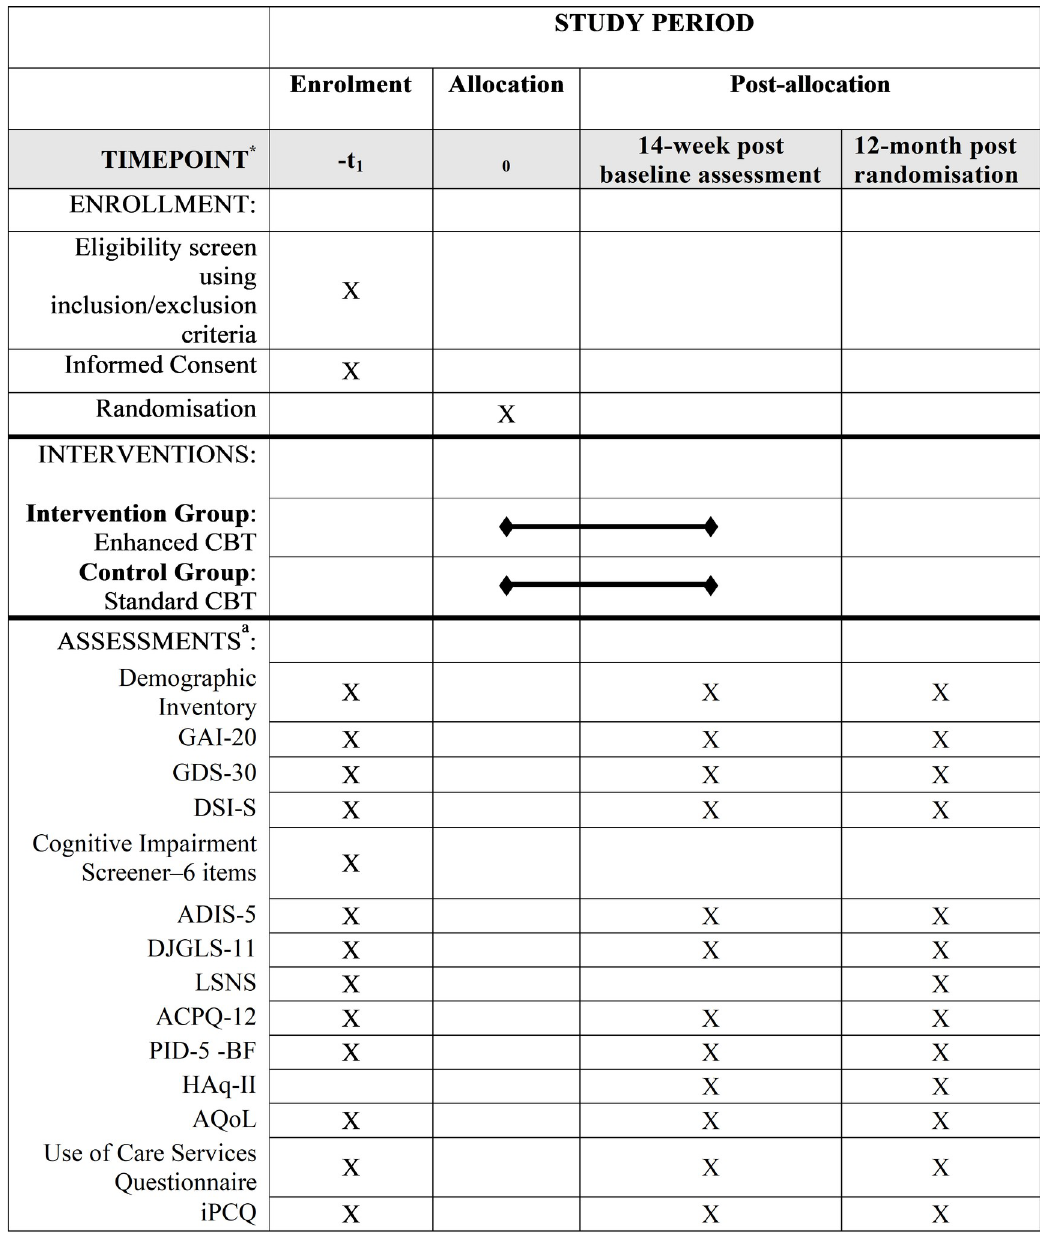
Fig 1. SPIRIT schedule of enrolment, interventions, and assessments. � -t1 = Baseline assessment. NOTE: GAI-20 = Geriatric Anxiety Inventory-20 items; GDS-30 = Geriatric Depression Scale-30 items; DSI-S = Depressive Symptoms Inventory–Suicide Subscale; ADIS-5 = The Anxiety Disorders Interview Schedule 5th edition; DJGLS-1 1 = De Jong Gierveld Loneliness Scales-11 items; LSNS = Lubben Social Network Scale; ACPQ-12 = Australian Community Participation Questionnaire-12 items; PID-5– BF = The Personality Inventory for DSM-5 Brief Form; HAq-II = Helping Alliance Questionnaire; AQoL = Assessment of Quality of Life; iPCQ = iMTA Productivity Cost Questionnaire. a Measures will be administered over the phone, online or paper based (participant’s